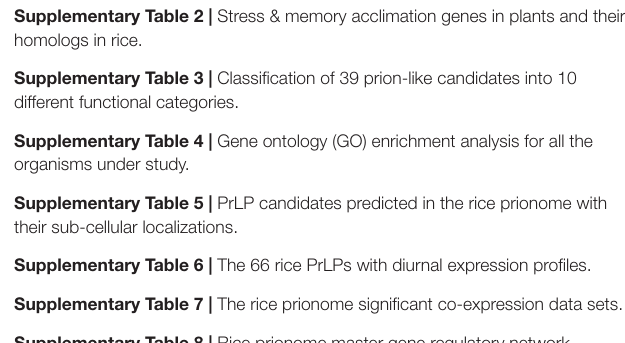
Supplementary Table 1 ). The values of log2FC were compared for the respective treatments against the untreated control in each case. The data were plotted as heatmaps using R software.